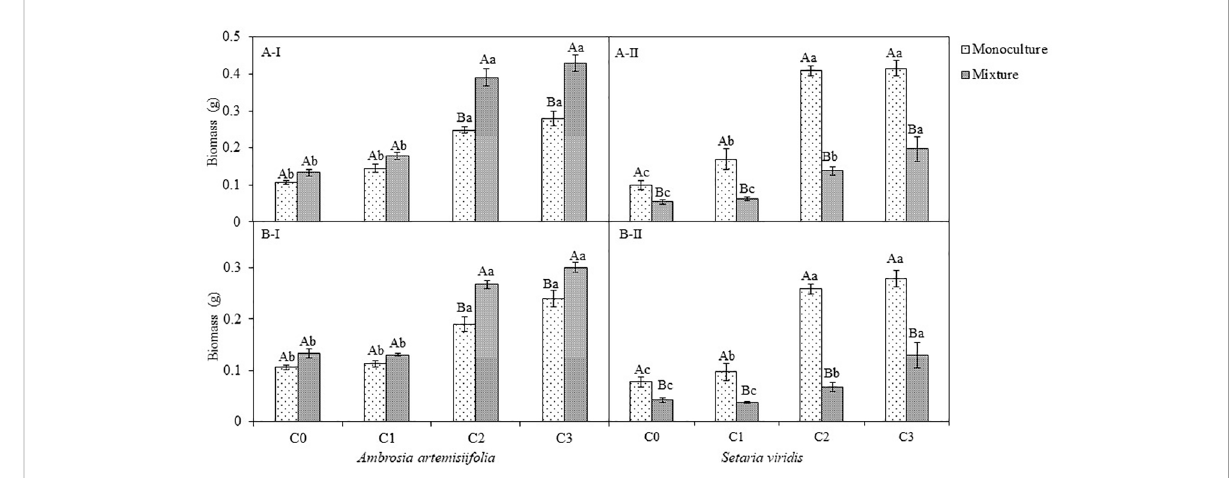
FIGURE 4 Effects of different concentration of B megaterium from the rhizosphere soil of A artemisiifolia (A) or of S. viridis (B) on plant biomass, C0, control; C1: 5X 10 8 cfu/mL of B. megaterium ; C2: 15 X 10 8 cfu/mL of B. megaterium ; C3: 30 X 10 8 cfu/mL of B. megaterium . A-I and A-II represent the biomass of A artemisiifolia and S. viridis when B megaterium from the rhizosphere soil of A artemisiifolia was inoculated respectively. B-I and B-II represent the biomass of A artemisiifolia and S. viridis when B megaterium from the rhizosphere soil of S. viridis was inoculated respectively. Different uppercase letters indicate signi fi cant differences between in the mixture and in the monoculture treatments at P <0.05. Different lowercase letters indicate signi fi cant differences among different concentrations of B megaterium at P <0.05. Error bars represent SD of mean ( n